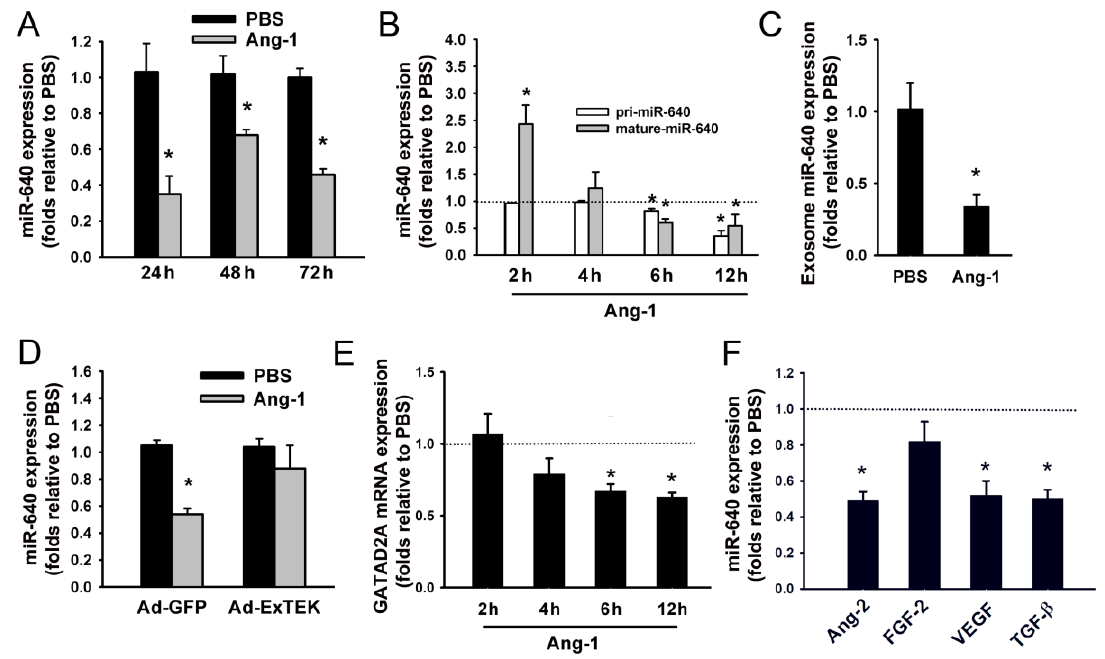
Figure 1. Regulation of miR-640 expression. ( A ): Expression of mature miR-640 in human umbilical vein endothelial cells (HUVECs) exposed to PBS (control), or Ang-1 for 24, 48, and 72 h. Values are means ± SEM, expressed as folds relative to PBS. * p < 0.05, compared to PBS. ( B ): Expression of pri-miR-640 and mature miR-640 in HUVECs exposed to PBS, or Ang-1 for 2, 4, 6, and 12 h. * p < 0.05, compared to PBS. ( C ): miR-640 levels in HUVEC exosomes in response to 24 h exposure to PBS, or Ang-1. * p < 0.05, compared to PBS. ( D ): miR-640 expression in HUVECs infected with Ad-GFP or Ad-ExTEK and then exposed to PBS or Ang-1 for 24 h. * p < 0.05, compared to PBS. ( E ): Expression of GATAD2A in HUVECs exposed to PBS, or Ang-1 for 2, 4, 6, and 12 h. Values are expressed as expressed as folds relative to PBS. * p < 0.05, compared to PBS. ( F ): Expression of miR-640 in HUVECs exposed to PBS, Ang-2, FGF-2, VEGF, or TGF- β . Values are expressed as folds relative to PBS. * p < 0.05, compared to PBS.